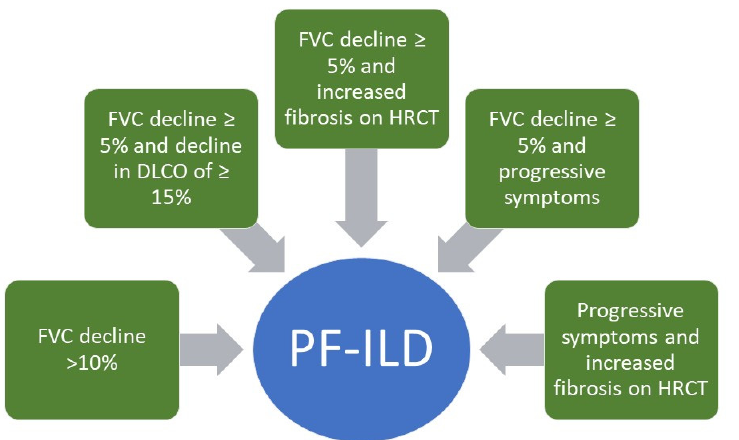
Figure 3. Definition of PF-ILD, adapted from George et al. [46]. Definition was developed based on inclusion criteria from available studies of antifibrotics in this condition. Progression is defined based on decrement in forced vital capacity (FVC), diffusion capacity for carbon monoxide (DLCO), progressive symptoms, or increased radiographic fibrosis as assessed by an expert thoracic radiologist, noted on high resolution thoracic computed tomography (HRCT).